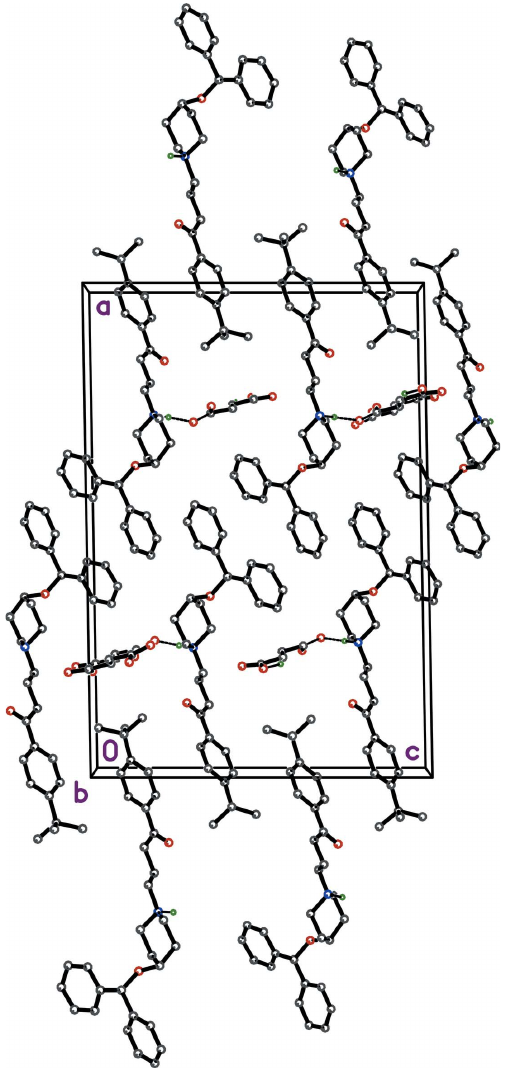
Figure 3 A packing plot of I viewed down the b -axis direction showing how the 4- t- butyl phenyl groups interdigitate with c -glide related copies of themselves, leading to layers that extend parallel to the bc -plane centered on a = 0 (and 1), and stack along the a -axis direction. The strong hydrogen bonds between cation and anion ( i.e. , N1—H1 N (cid:2)(cid:2)(cid:2) O4) are shown as thick dashed lines.